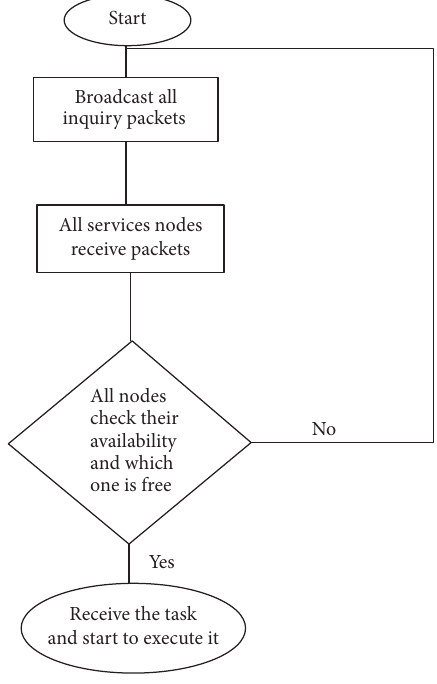
Figure 4: Router levels. Figure 5: CCA